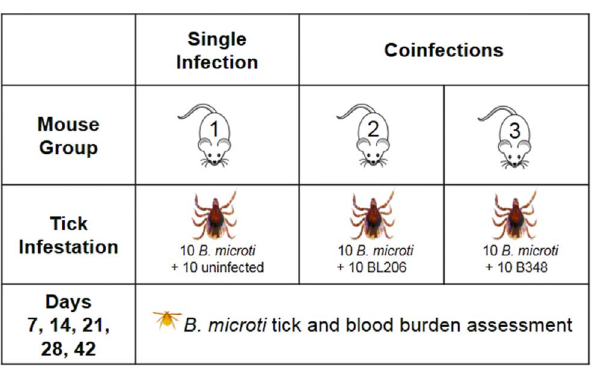
Fig. 1. Laboratory study design. Peromyscus leucopus mice were infected with Babesia microti alone (Group 1 [8 mice]) or coinfected with B. microti and one of two strains of Borrelia burgdorferi: BL206 (Group 2 [3 mice]) or B348 (Group 3 [8 mice]). Xenodiagnosis was performed at 7, 14, 21, 28, 42 days. B. microti infection was determined in ticks at 7, 14, 21, 28, 42 days by qPCR. B. microti infection was determined in mouse blood at weeks 7, 14, 28, 42 days by flow